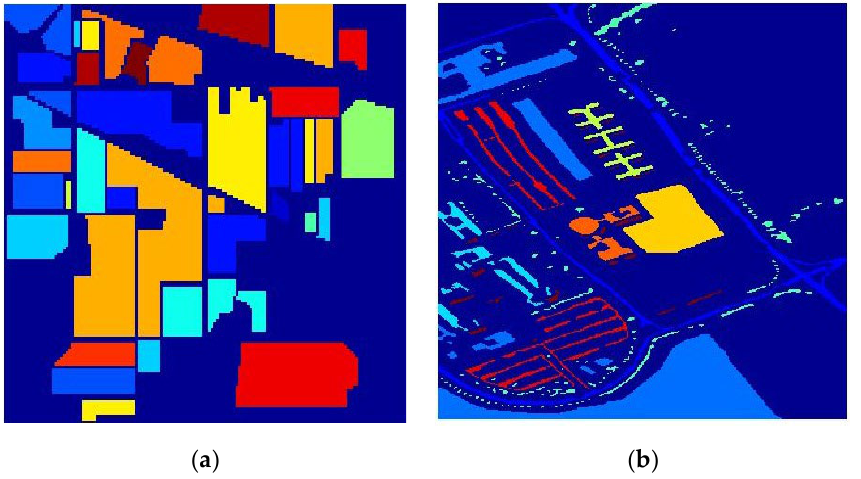
Figure 8. Labeled output for: ( a ) Indian Pines and ( b ) Pavia University.